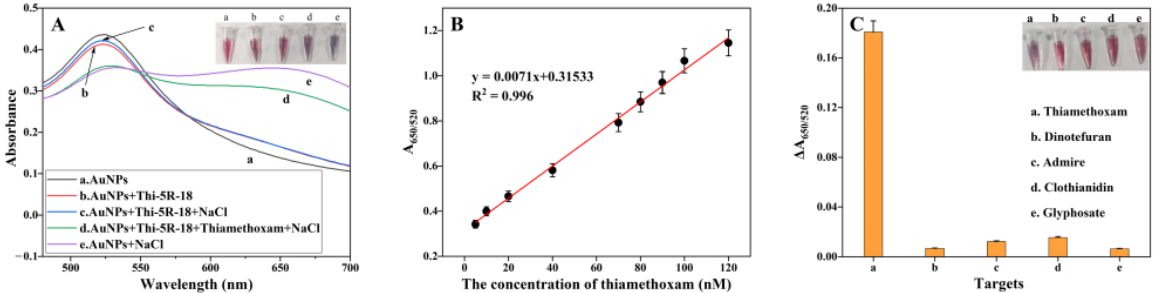
Figure 7. ( A ) UV-vis spectroscopy of AuNPs under different conditions. ( B )The linear relationship between the value of A 650/520 and the concentration of thiamethoxam. ( C ) The value of A 650/520 for different targets.